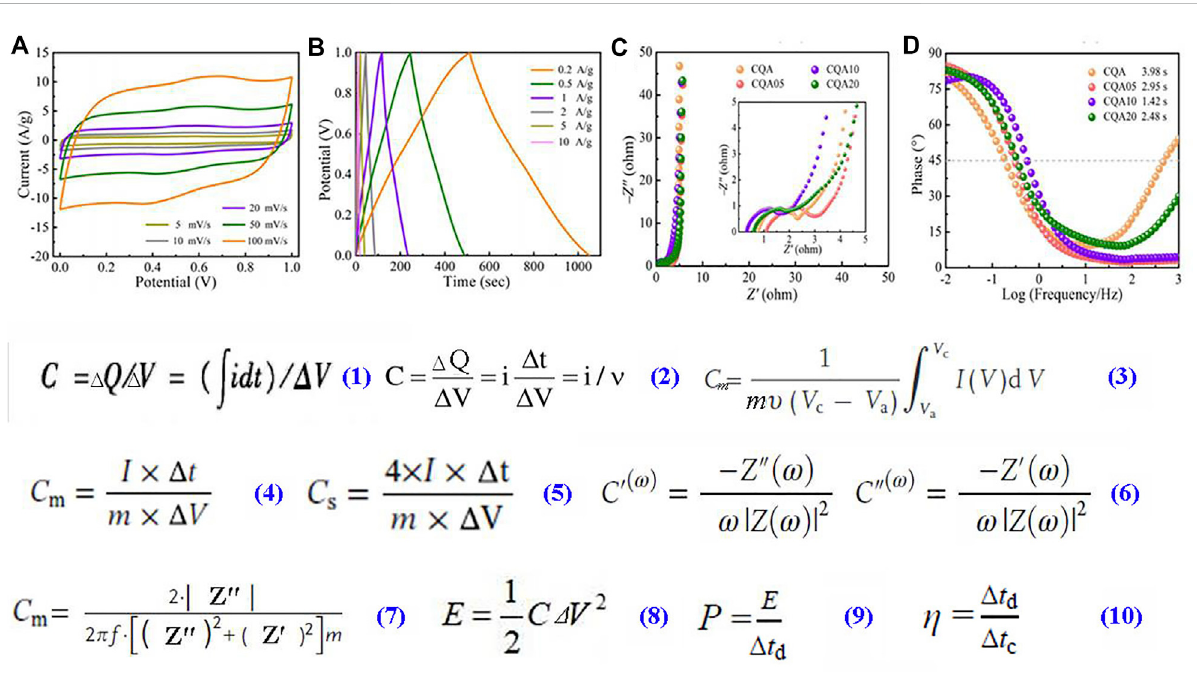
FIGURE 1 An expression of a typical curves of (A) CV and (B) GCD, (C) Nyquist plots, (D) Bode phase diagram (Mansuera et al., 2022); equations for calculations of capacitances (C, C m , Cs, C ′ , C ″ ), energy and power density (E, P) as well as coulombic ef fi ciency ( η ) (Taberna et al., 2003; Wei et al., 2010; Cheng et al.,